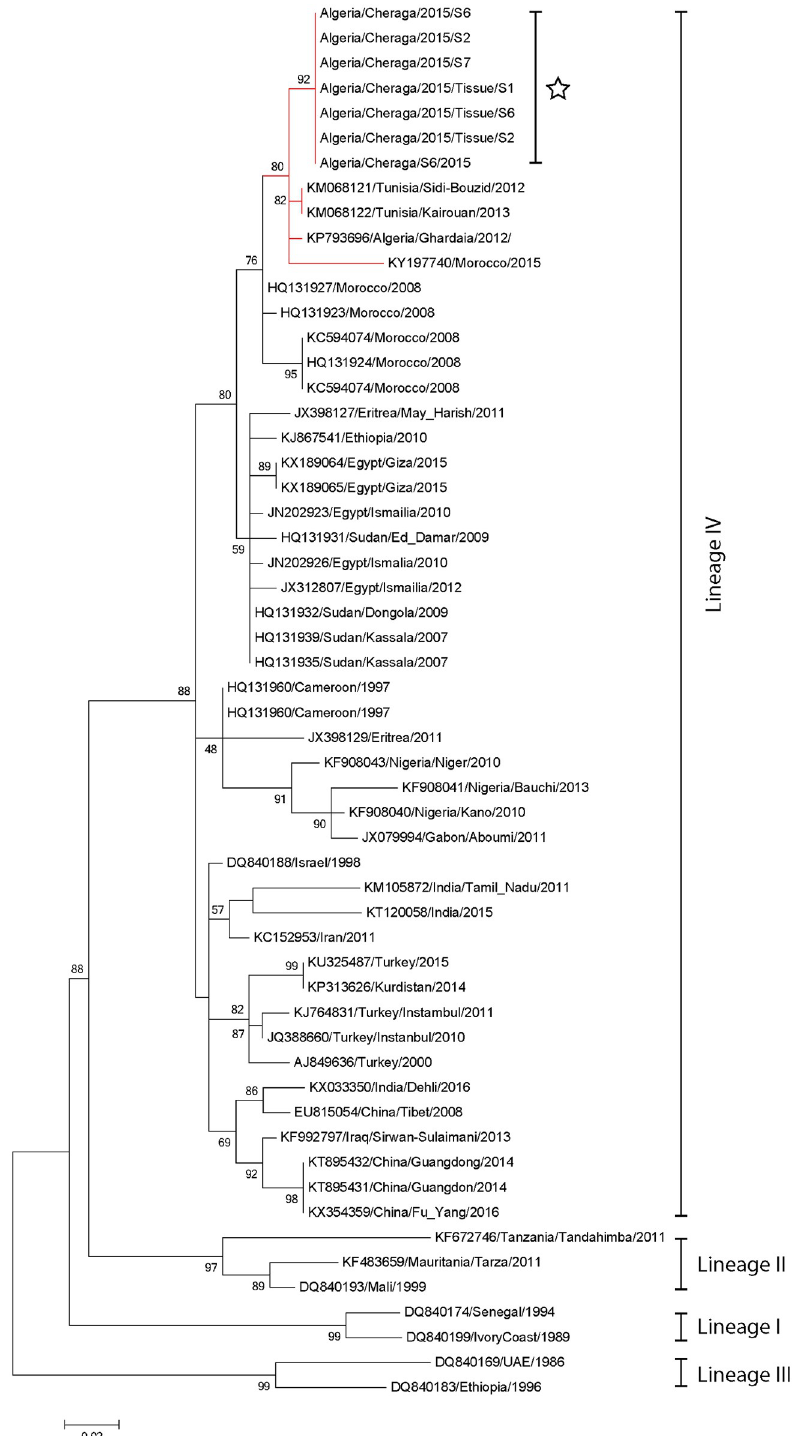
Fig 4. Neighbor-joining tree based on a 255 nt partial PPRV N gene sequence (1360–1614nt) of peste des petits ruminants virus isolated from a 2015Algerian outbreak (White star) (KY885101, KY885102, KY885103) and selectedsequences from GenBank. Nodes are labeled with bootstrapvalues obtained following5000 replicationswith the Kimura 2-parametermodel. GenBank accession numbers are given againsteach sequence.Scale bar indicates nucleotide substitutionsper site. Branchesleadingto isolates which are obtainedfrom the Maghrebregionof North Africa are labeledin red. https://doi.org/10.1371/journal.pone.0175461.g004 PLOS ONE | https://doi.org/10.1371/journal.pone.0175461 April 20,